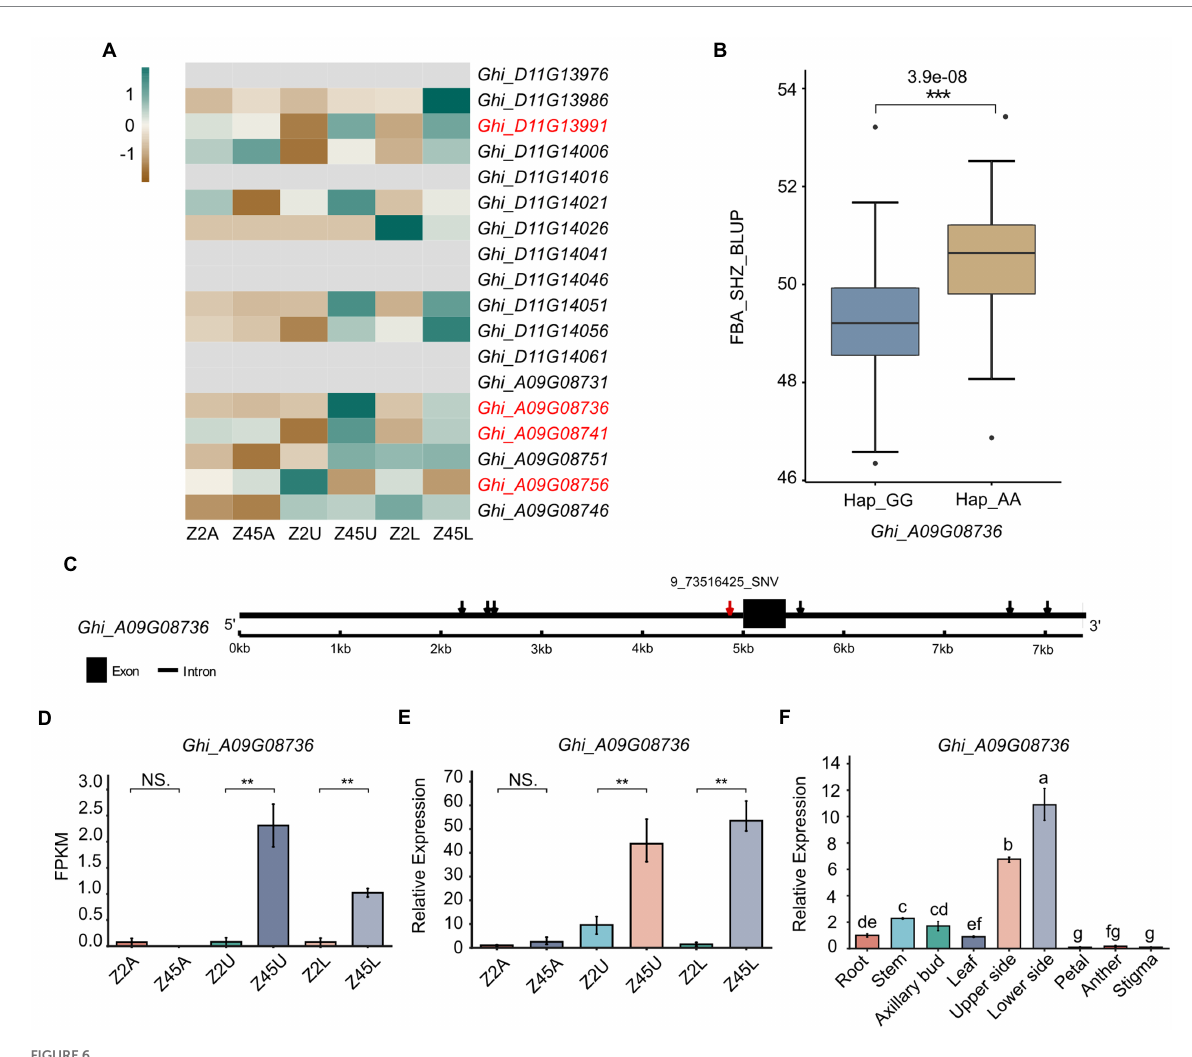
FIGURE 6 Variation analysis of candidate gene Ghi_A09G08736 in 163 Gossypium hirsutum accessions. (A) The expression patterns of 18 candidate genes detected by GWAS were shown by heat map. The red mark of genes indicates the DEGs between Z2 and Z45 detected by RNA-seq. (B) Haplotype analysis of the SNP 9_73516425_SNV for Ghi_A09G08736 were shown. (C) Gene structure of Ghi_A09G08736 was shown. Black rectangles and black lines indicate exon and introns, respectively. (D) Gene expression of Ghi_A09G08736 derived from RNA-seq data. (E) Gene expression of Ghi_A09G08736 derived from qRT-PCR analysis. (F) The tissue expression pattern of Ghi_A09G08736 in TM-1 were shown. **Significant difference ( p < 0.01), ***Significant difference ( p < 0.001), t -test. a-g mean significant difference ( p < 0.05), Duncan